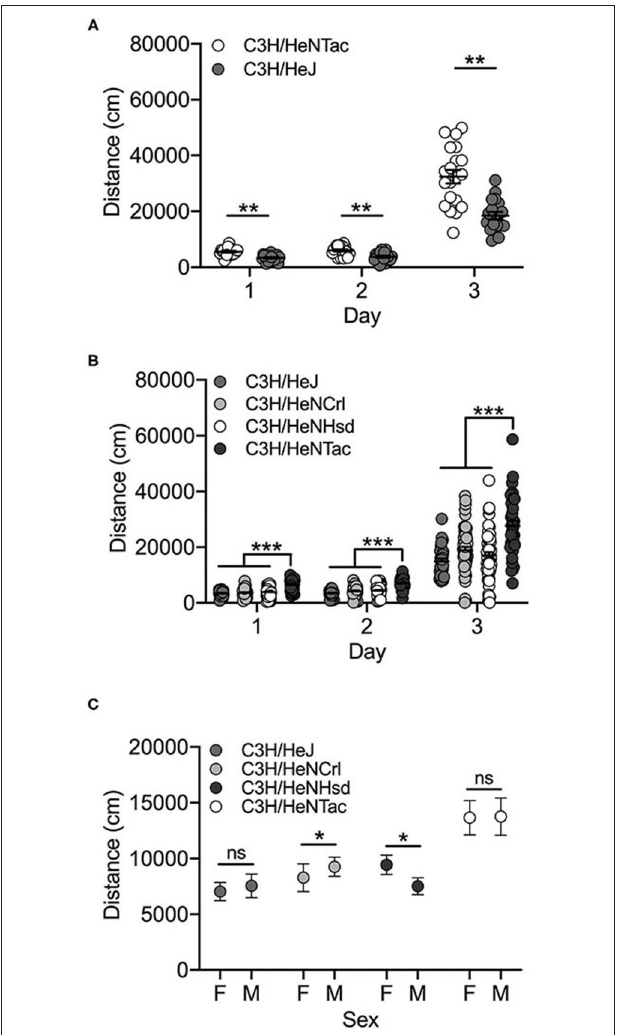
FIGURE 3 | C3H/HeNTac mice are more active than other C3H/He substrains. (A) Cohoused C3H/HeJ and C3H/HeNTac substrains are significantly activated by cocaine on Day 3 and C3H/HeNTac mice are significantly more active than C3H/HeJ mice regardless of treatment (saline, cocaine). (B) Non-cohoused C3H/He substrains are significantly activated in response to cocaine on Day 3 and C3H/HeNTac mice are significantly more active than C3H/HeJ, C3H/HeNCrl and C3H/HeNHsd substrains. (C) C3H/HeNCrl males are significantly more active than females and C3H/HeNHsd females are significantly more active than males. Each data point represents an individual mouse, error bars are standard error of the mean. * p < 0.05; ** p < 0.01; *** p <